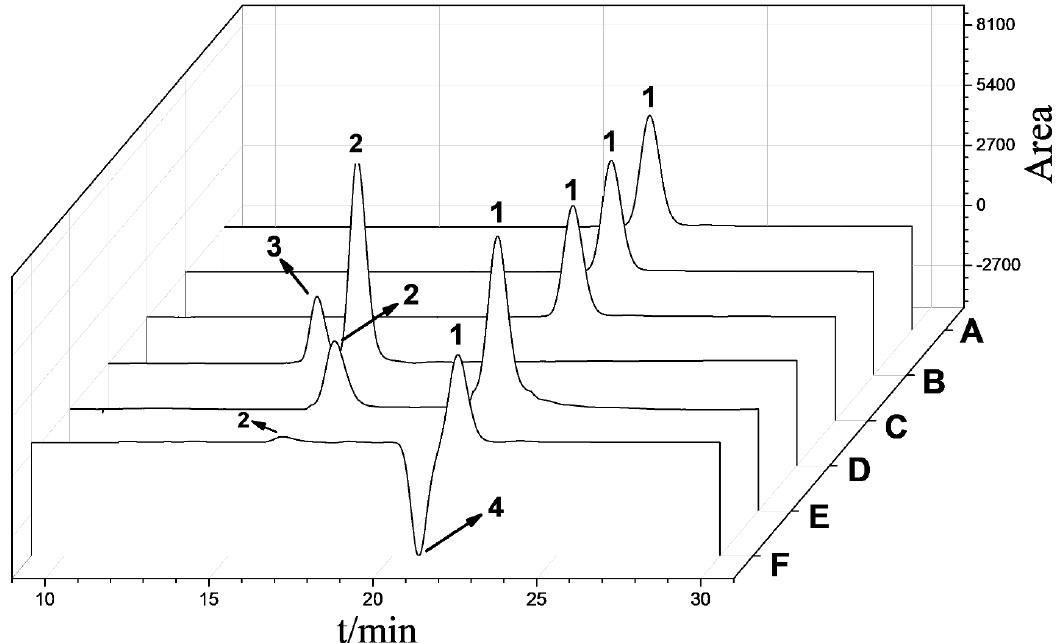
Figure 3. Chromatographic analysis during long-term ethanol electrolysis at different anode architectures: ( A ) MWCNT- COOH/linear poly(ethylenimine) (LPEI)/BSA (t = 0), ( B ) MWCNT-COOH/LPEI/BSA (t = 12 h), ( C ) MWCNT- COOH/LPEI/oxalate oxidase (OxOx) (t = 12 h), ( E ) MWCNT-COOH/TEMPO-LPEI/BSA (t = 12 h), and (F) MWCNT- COOH/TEMPO-LPEI/OxOx (t = 12 h) and during 30 mM acetic acid electrolysis at ( D ) MWCNT-COOH/LPEI/OxOx (t = 12 h). Peaks 1, 2, 3, and 4 correspond to ethanol, acetic acid, formic acid, and carbon dioxide, respectively. Reprinted with permission from [33]. Copyright 2020.